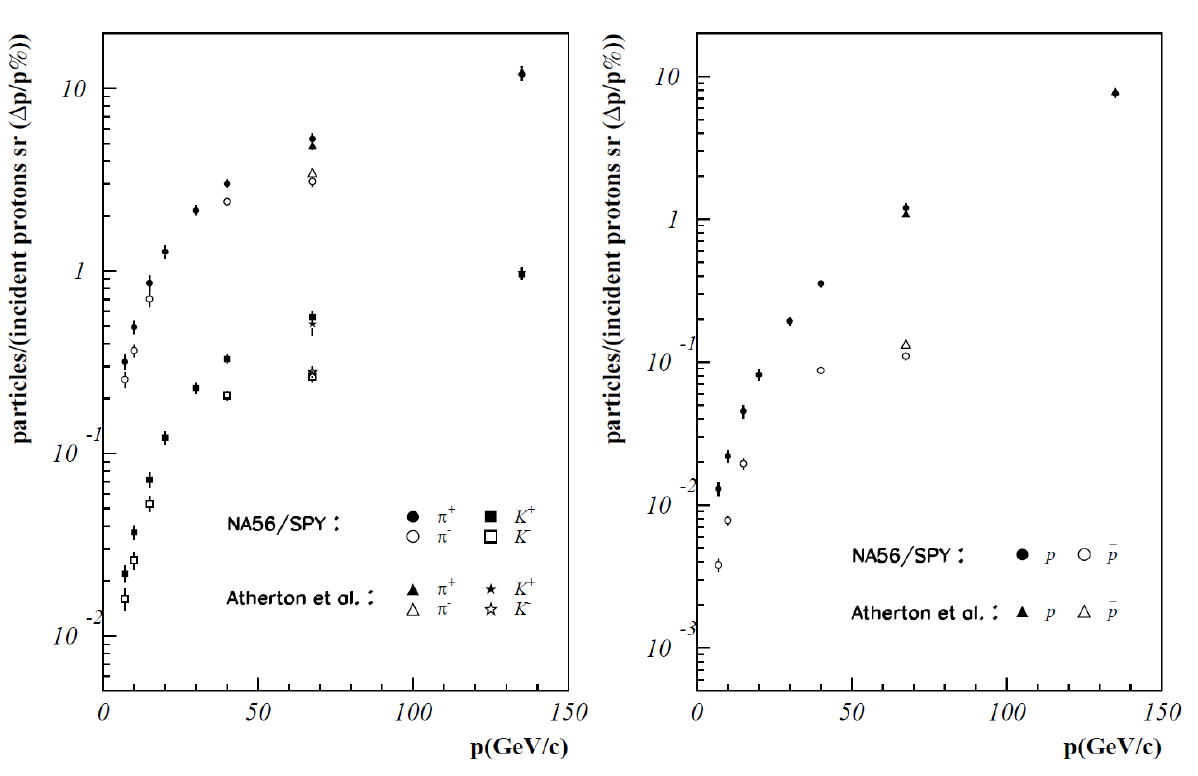
Figure 5. Pion and kaon yields from NA56/SPY. Reprinted with permission from Ref. [101]. Copyright 1999